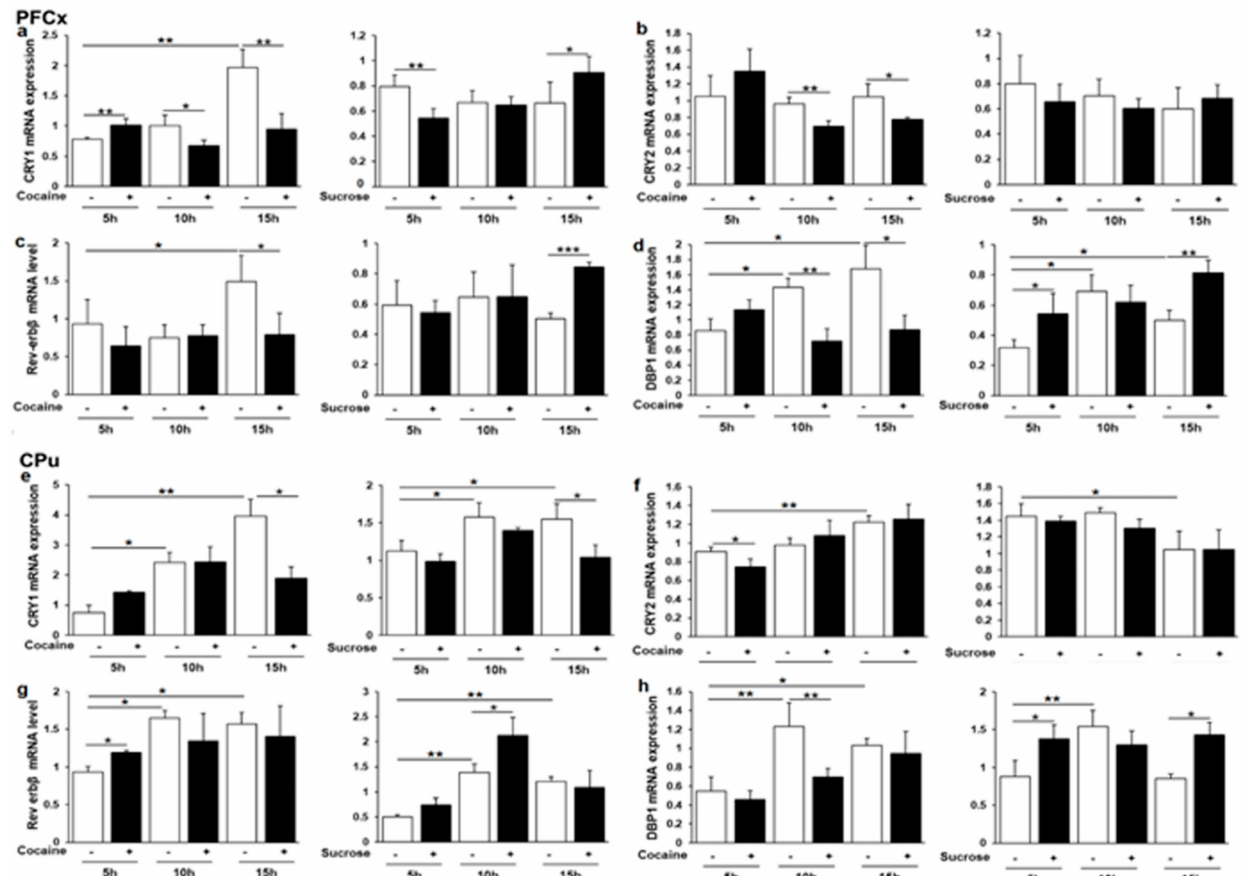
Figure 5. Clock , Bmal1 , Per1 and Per2 gene expression in the PFCx and the CPu ( a,b,d–f,h ). Relative mRNA levels ( c,g ) of circadian genes were analyzed as described in Figure 3. Statistical analysis performed was one-way ANOVA followed by Newman-Keuls post hoc test when required. Significant differences between control and treated groups and within control groups relative to ZT 6 (5 h after administration) are also indicated with n = 4–5 per group. * p < 0.05, ** p < 0.01, *** p <